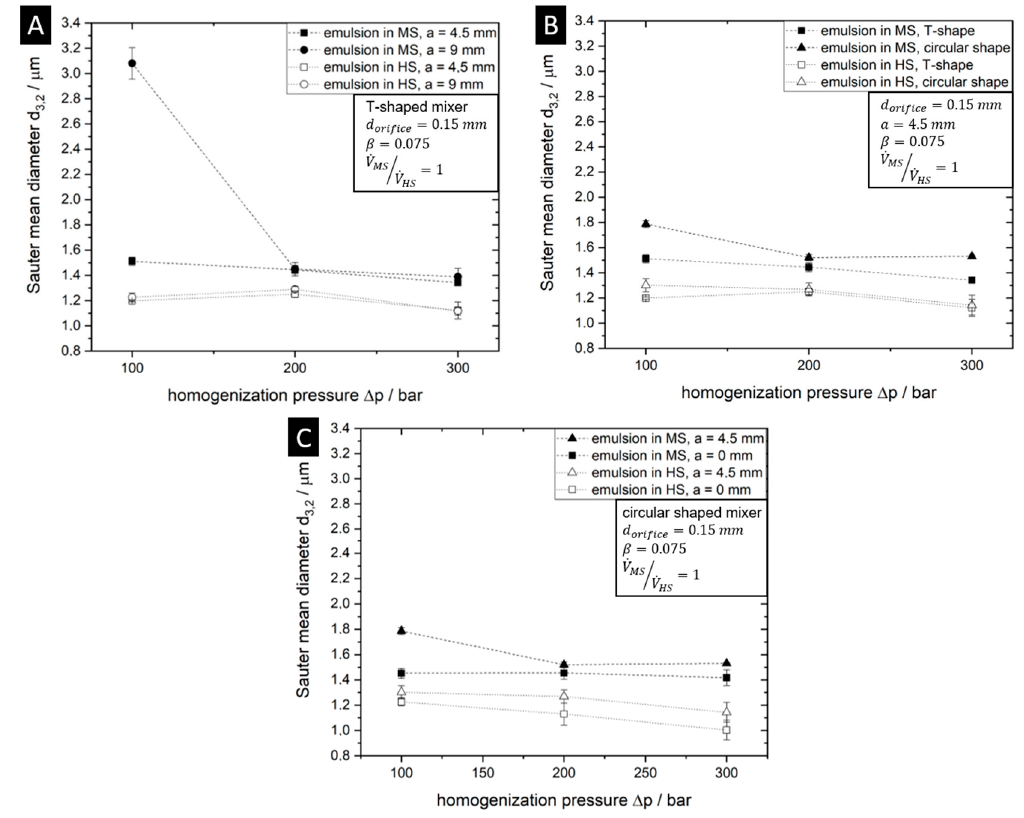
Figure 11. Influence of geometry of mixing unit on d 3,2 . ( A ) displays 𝑑 (cid:2871),(cid:2870) for the T ‐ shaped mixer under variation of a, ( B ) compares d (cid:2871),(cid:2870) for both mixers and a = 4.5 mm and ( C ) displays d (cid:2871),(cid:2870) for the circular shaped mixer under variation of a